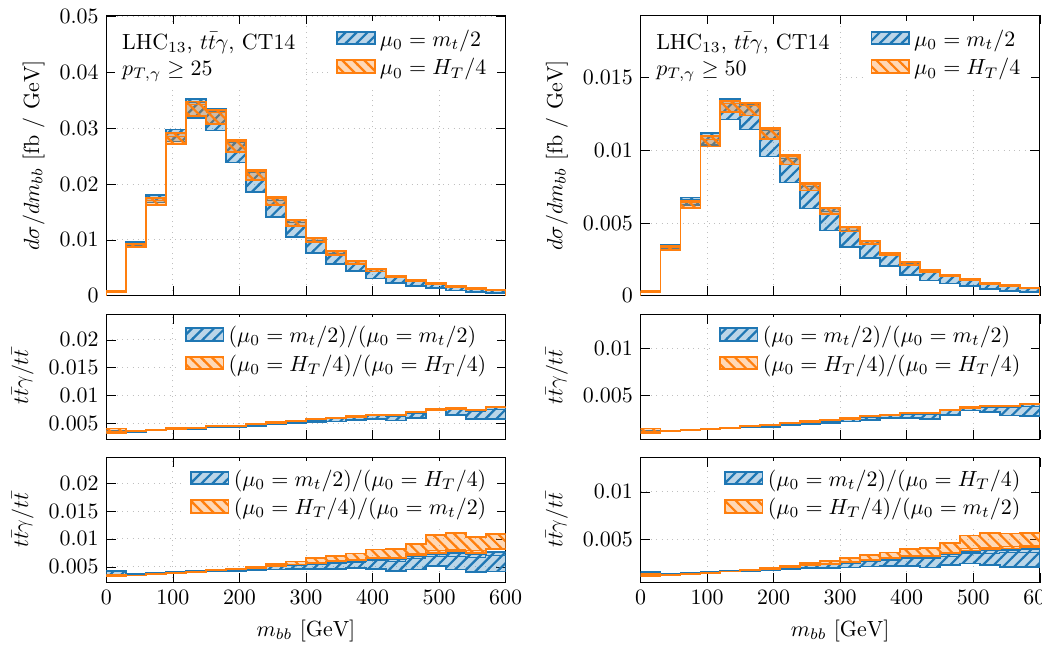
Figure 4 . Di(cid:11)erential cross section distributions as a function of the invariant mass of two b -jets for the pp e + (cid:23) e (cid:22) (cid:0) (cid:22) (cid:23) (cid:22) b (cid:22) b(cid:13) + X process at the LHC run II with p s = 13 TeV. The upper plots show ! absolute NLO predictions for p T;(cid:13) > 25 GeV (left panel) and p T;(cid:13) > 50 GeV (right panel) together with the corresponding uncertainty bands resulting from scale variations. Renormalisation and factorisation scales are set to the common value (cid:22) R = (cid:22) F = (cid:22) 0 where (cid:22) 0 = m t = 2 and H T = 4. The CT14 PDF set is employed. The lower panels display di(cid:11)erential cross section ratios together with their uncertainty bands. In the (cid:12)rst case (middle panel), the same (cid:12)xed (dynamical) scale choice is employed in the numerator and the denominator of the cross section ratio. In the second case (bottom panel), di(cid:11)erent scale choices in the numerator and in the denominator have been assumed. of (cid:22) 1 = (cid:22) 2 = (cid:22) 0 = m t = 2 a reduction almost by a factor of 2 can be noticed.